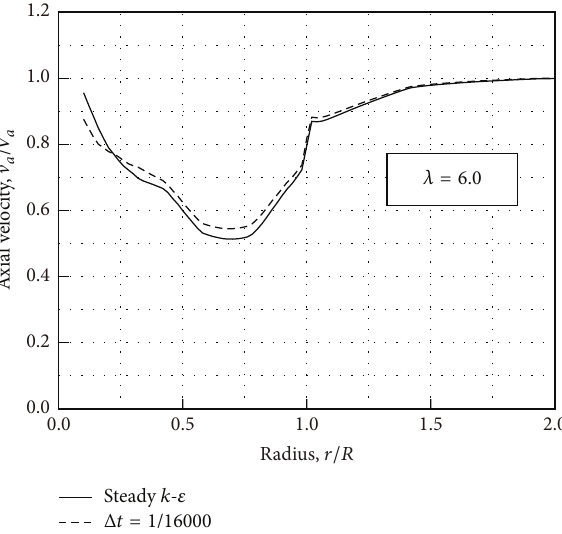
Figure 12: Local axial velocity at rotor for tip speed ratio 𝜆 = 6